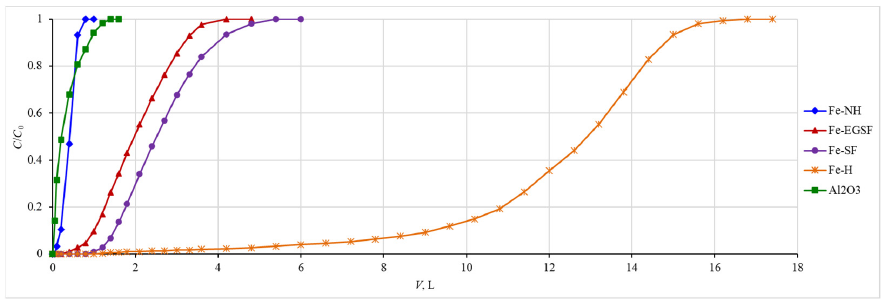
Water 2022 , 14 , 2303 Figure 10. Dynamic curves of sorption of stable phosphorus as a tracer of sorption efficiency.